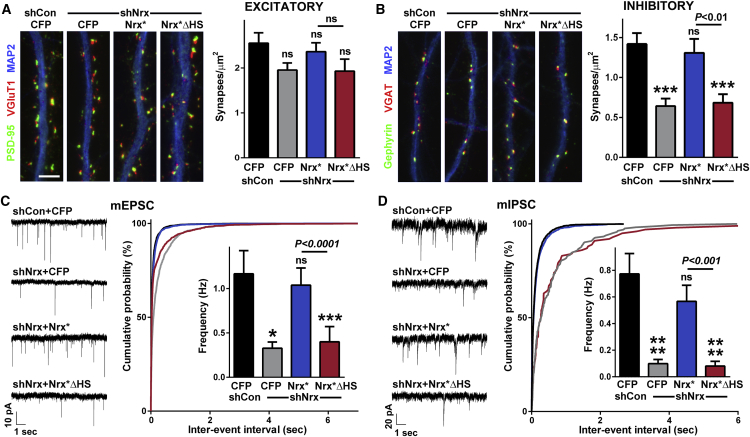
Nrx HS Modification Is Required for Development of Functional Synapses in Cultured Hippocampal Neurons(A) Density of excitatory synapses (apposed PSD-95-VGluT1 puncta) was not significantly altered by Nrx knockdown.(B) Density of inhibitory synapses (apposed gephyrin-VGAT puncta) was reduced by Nrx knockdown and rescued by RNAi-resistant Nrx∗ but not Nrx∗ΔHS.(C and D) Excitatory and inhibitory transmission were impaired by Nrx knockdown and rescued by RNAi-resistant Nrx∗, but not Nrx∗ΔHS. All inter-event interval distributions were significantly different except that shCon+CFP versus shNrx+Nrx∗, and shNrx+CFP versus shNrx+Nrx∗ΔHS, did not differ for mIPSCs; comparing Nrx∗ΔHS with Nrx∗ rescue gave p < 0.05 for mEPSCs and p < 0.001 for mIPSCs by Kruskal-Wallis and Dunn’s tests. Amplitude data are shown in Figure S3C.∗p < 0.05, ∗∗∗p < 0.001, and ∗∗∗∗p < 0.0001 by Kruskal-Wallis and Dunn’s tests compared to shCon+CFP; n = 39–55 (A and B), 21–32 (C), or 18–20 (D) from 3–4 independent experiments. shNrx plus Nrx∗ΔHS not significant compared with shNrx plus CFP for all assays. Error bars represent SEM. Scale bars: 5 μm.See also Figure S3.